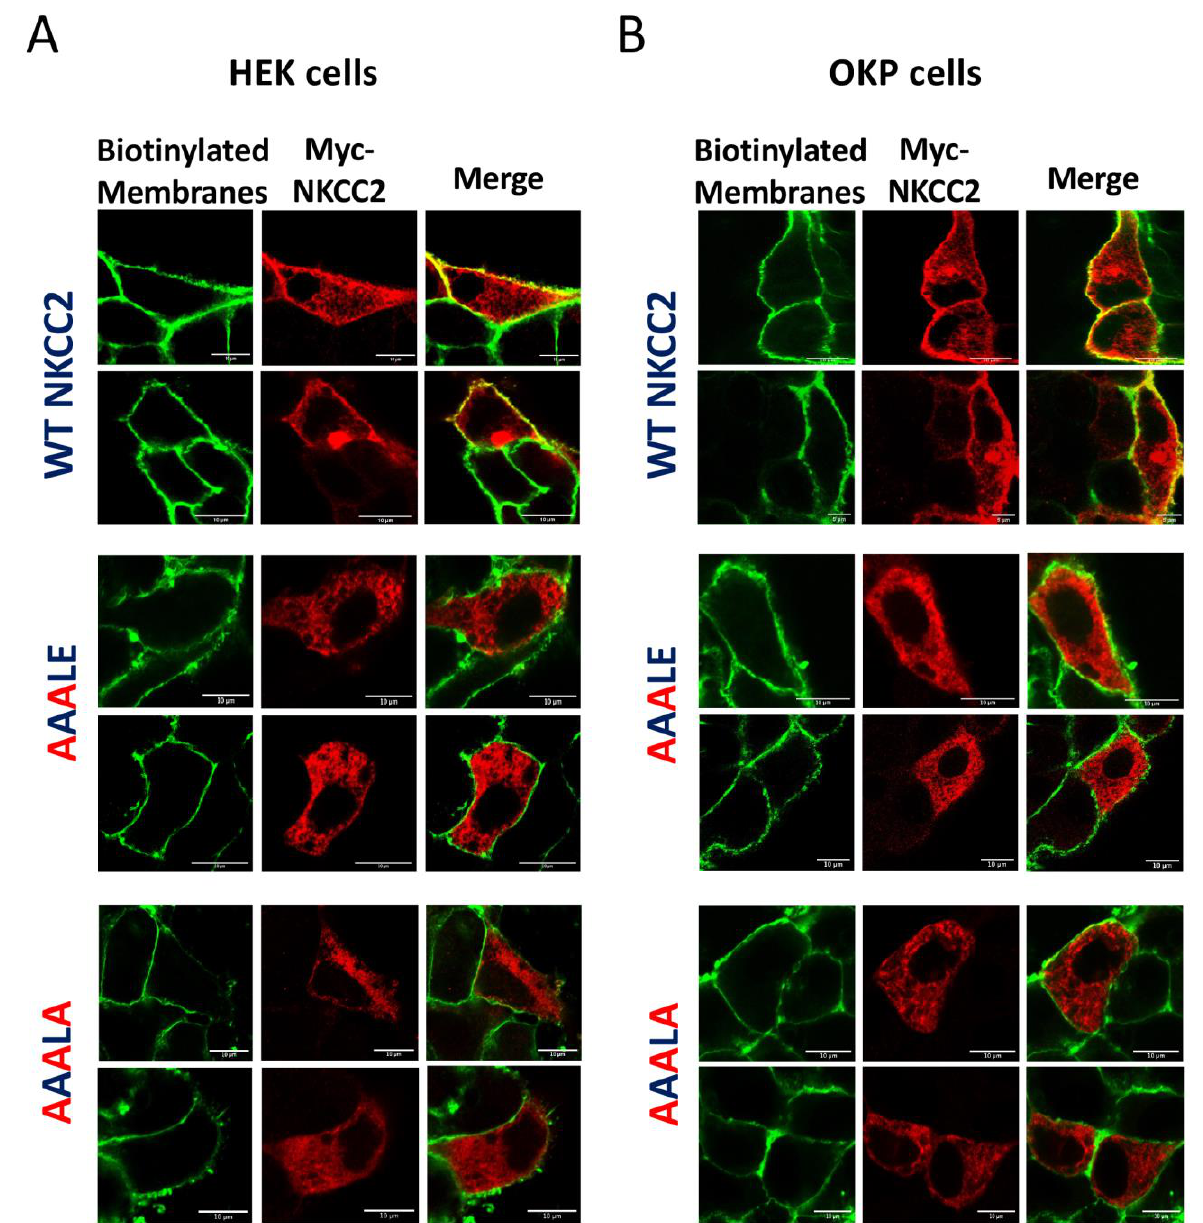
Figure 3. Mutating the 1019 DAELE 1023 motif impairs NKCC2 cell surface expression. Membrane proteins of confluent HEK ( A ) or OKP cells ( B ) transiently transfected with wild-type NKCC2 or 1019 AAALE 1023 1019 AAALA 1023 mutants, were biotinylated at 4 ◦ C with the biotinylation reagent sulfo-NHS-SS-biotin. Then, the monolayers were fixed and stained for Myc-tagged NKCC2 proteins (Texas-red, red) and cell surface biotin (avidin-Cy2, green). The stained specimens were evaluated by confocal microscopy. The yellow color in the merged image indicates co-localization of myc-NKCC2 (red) with biotin-Cy2 (green). Bars, 10 µ